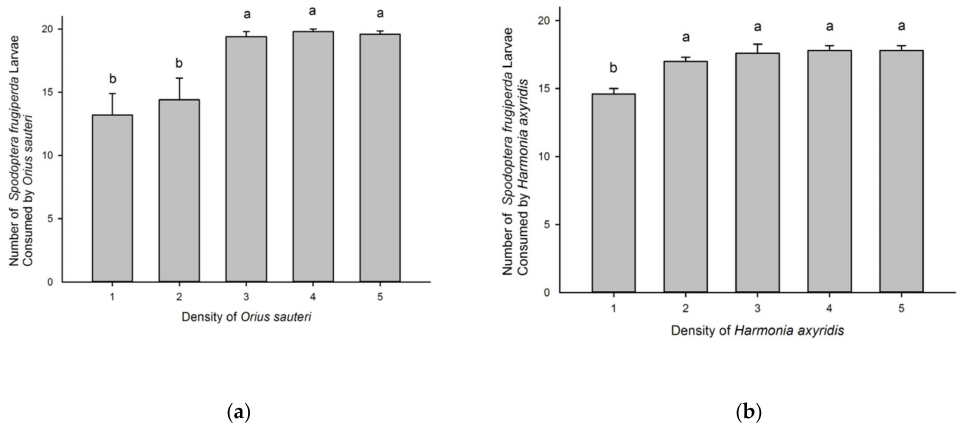
Figure 2. The mean ( ± SE) number of Spodoptera frugiperda 1st instar larvae consumed by Orius sauteri ( a ) and Harmonia axyridis ( b ) at different predator densities. Different letters signify significant differences at p < 0.05.